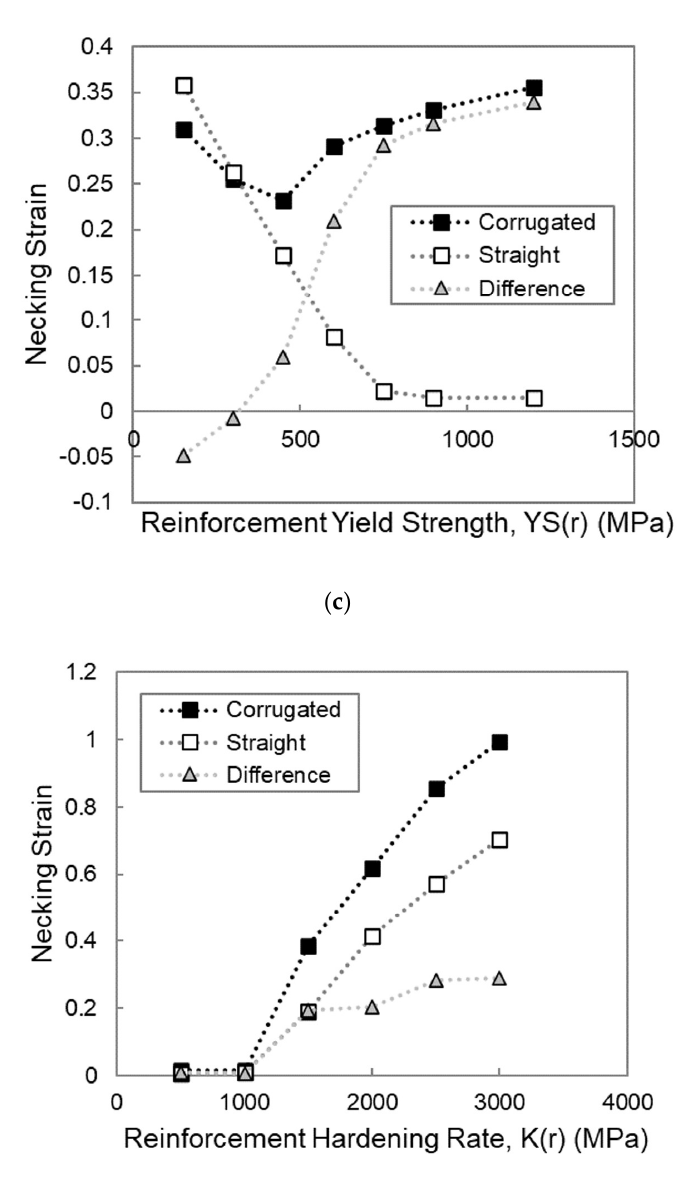
Figure 3 . Plots of necking strain as a function of different material parameters from FEM simulations of straight and corrugation reinforced composites. The plots also include the difference in necking strain between the corrugated and straight simulations for each value of the parameter tested. The parameters include ( a ) matrix yield strength, YS(m); ( b ) matrix hardening rate, K(m); ( c ) reinforcement yield strength, YS(r); ( d ) reinforcement hardening rate, K(r).